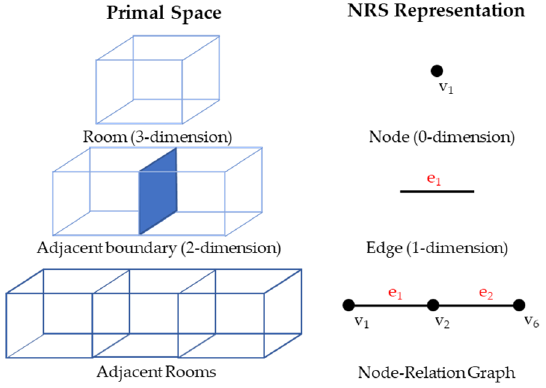
Figure 4. NRS Representation of 3D indoor space.